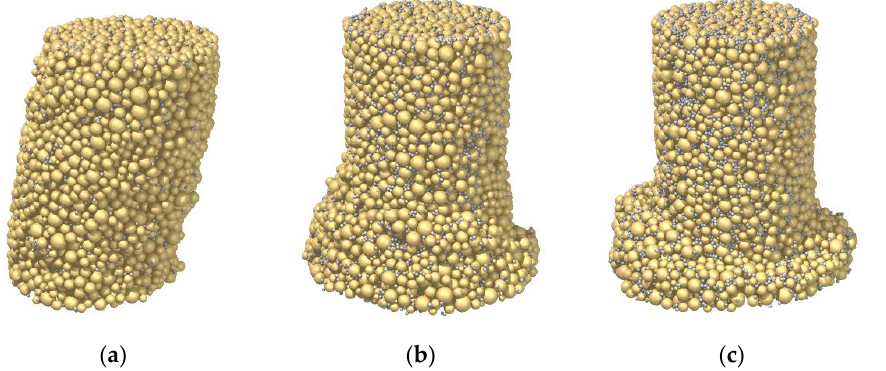
Figure 6. Influence of the cement – sand ratio on the failure mode: ( a ) Sample C28_R1L; ( b ) Sample C28_R3L; ( c ) Sample C28_R5L.